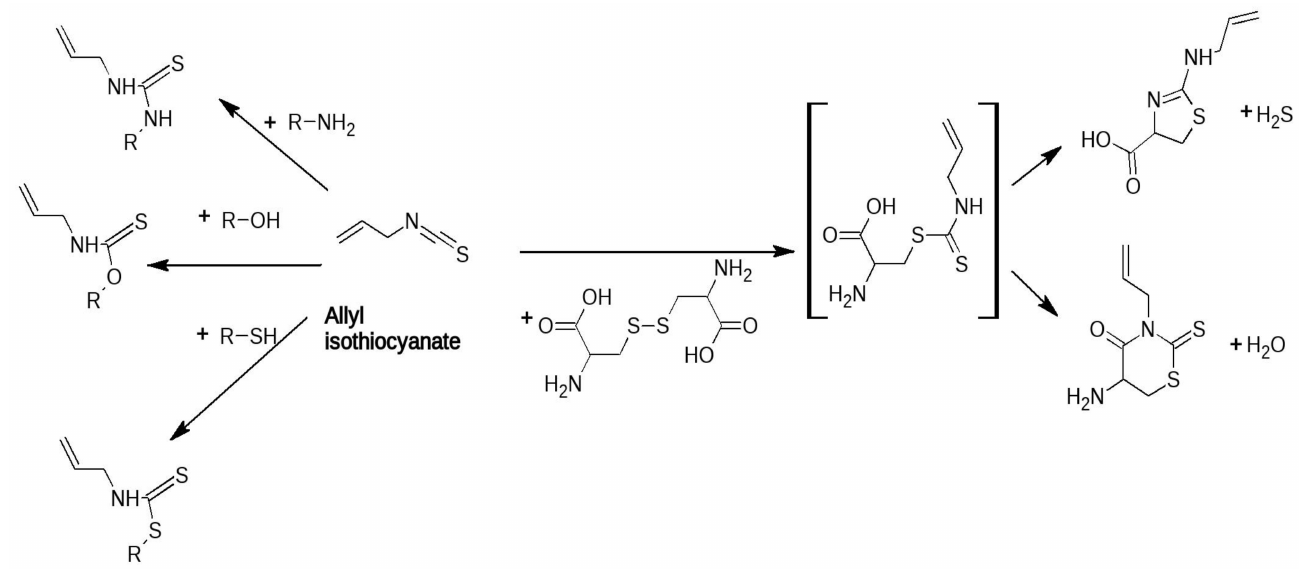
Figure 3. Reaction of isothiocyanates with nucleophiles. Compiled from data in